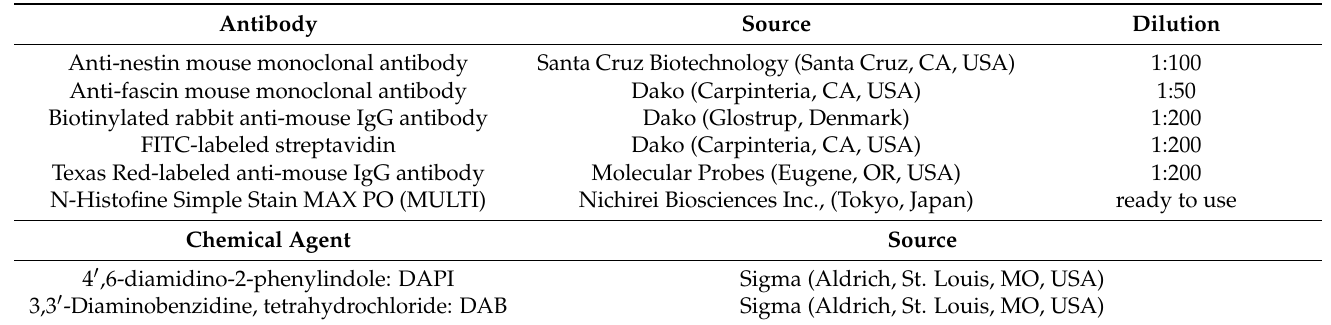
Table 2. Antibodies and chemical agents used in